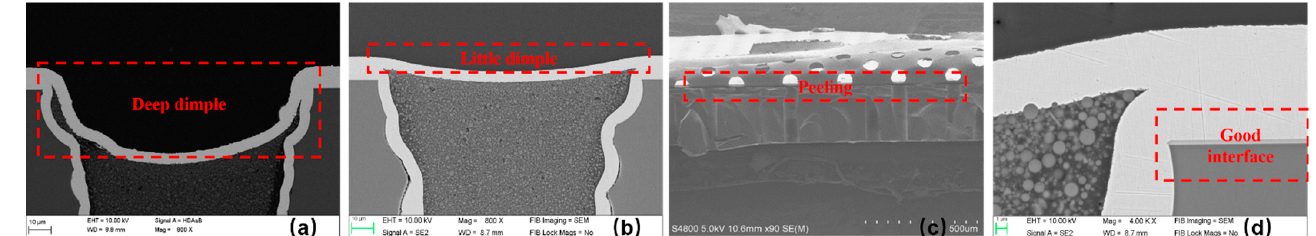
Figure 6. Fine-controlled via plugging process. ( a ) is a deep dimple on the surface after filling the via caused by excessive development. ( b ) is a near-flat orifice stat, which formed due to a finely controlled via plugging process. ( c ) is an example of an unclean development process that led to peeling. There are residual particles of the photosensitive material on the fused silica glass surface, resulting in poor interfacial bonding. ( d ) shows good bonding on the interface between the fused silica glass and metal after a finely controlled via plugging process.